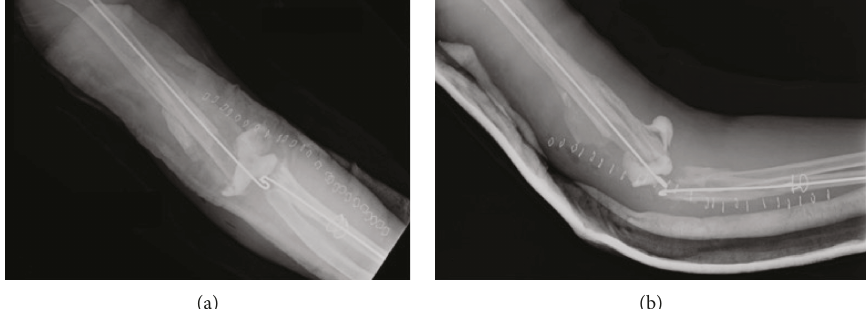
Figure 4: (a) AP and (b) lateral radiographs obtained following resection arthroplasty with placement of an amphotericin, vancomycin, and tobramycin-impregnated cement spacer.